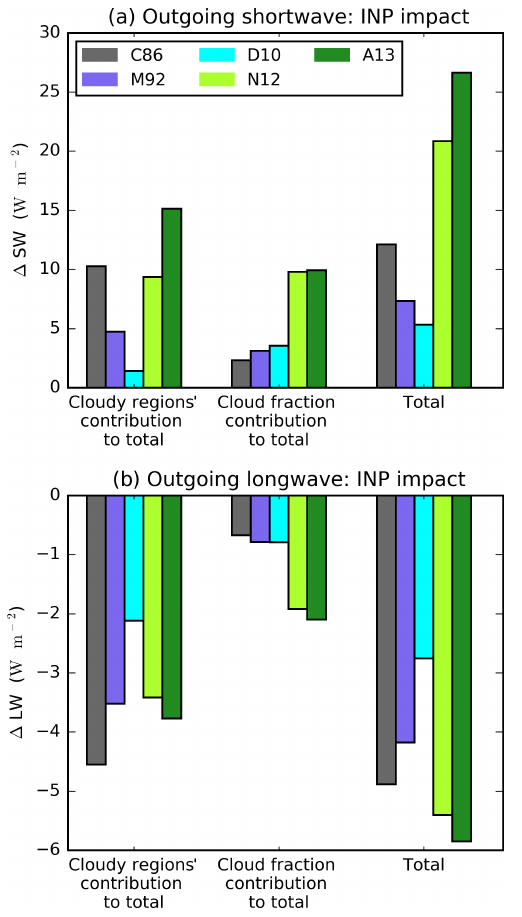
Figure A4. Profiles of some microphysical properties of the simu- lated clouds. Mean in-cloud ice particle production rates from sec- ondary (a) and homogeneous (b) freezing, snow mass concentration (c) and graupel mass concentration (d)